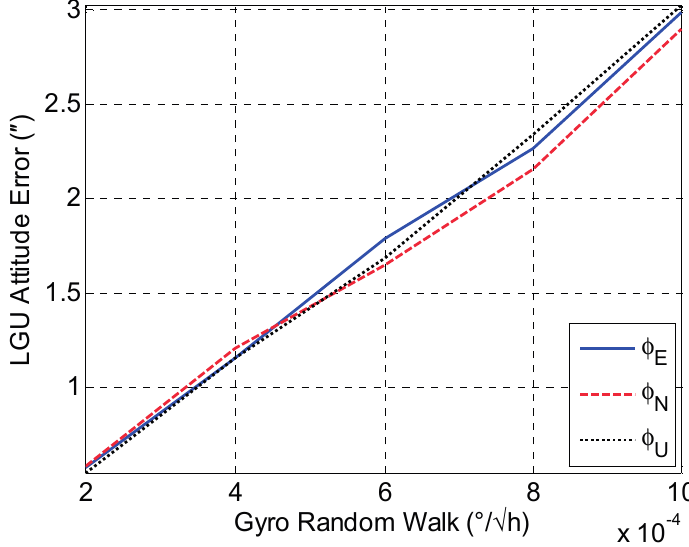
Figure 10. LGU attitude error with respect to gyro angular random walk (ARW)